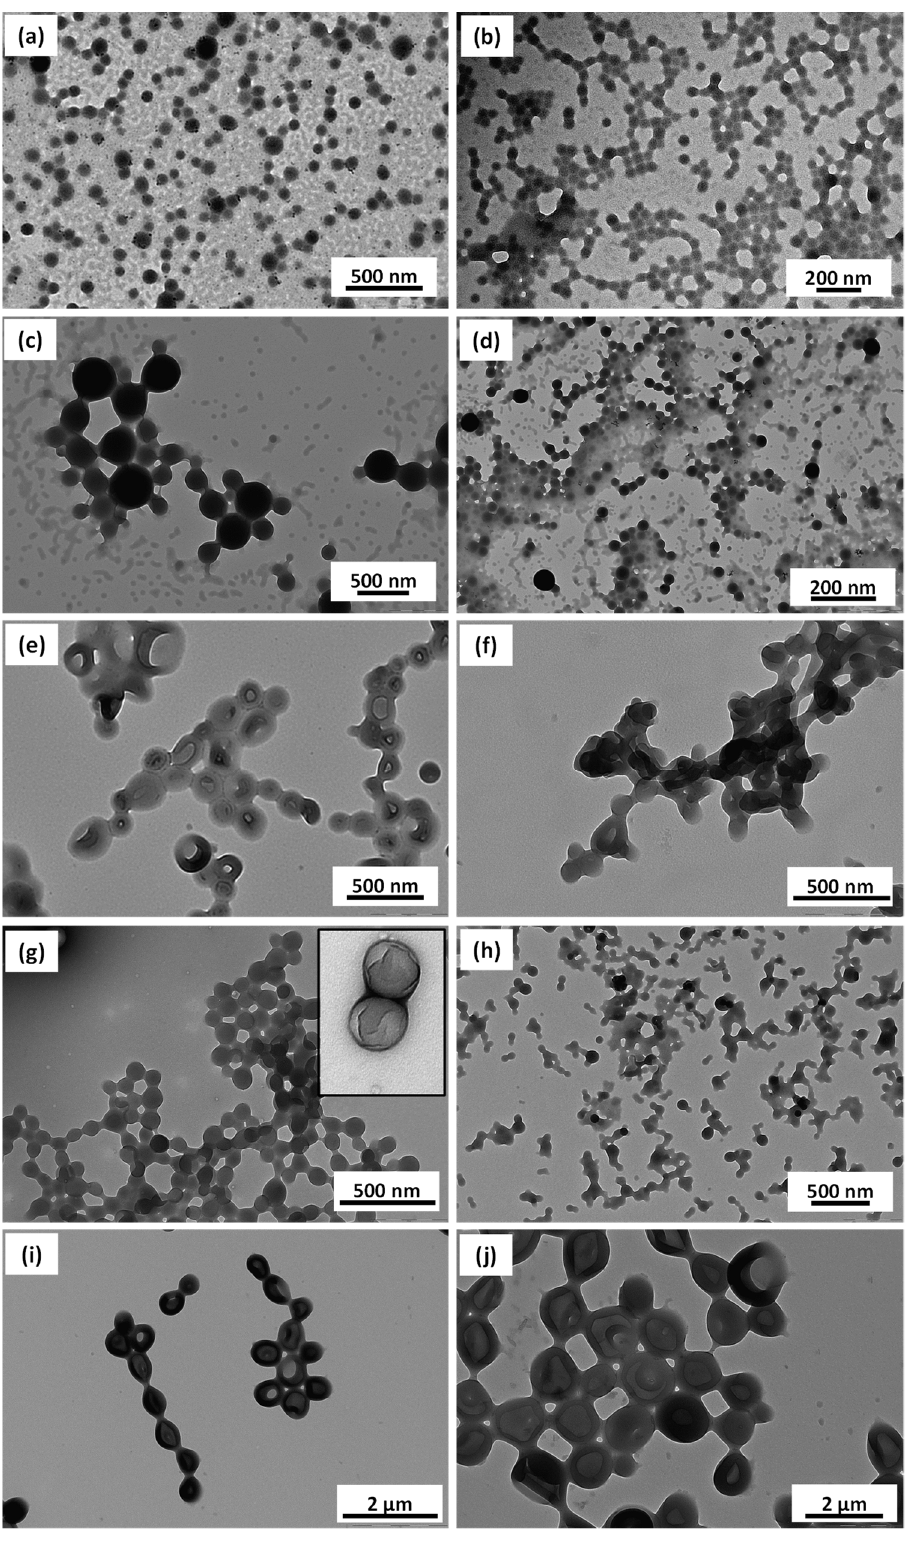
Figure 5. TEM images obtained for PDMA 39 -PBzMA x -PHFBMA y nano objects prepared at 10% w / w with ( a ) x = 69, y = 50 ( b ) x = 69, y = 99 ( c ) x = 69, y = 149 ( d ) x = 69, y = 196 ( e ) x = 99, y = 65 ( f ) x = 149, y = 141 ( g ) x = 198, y = 50 ( h ) x = 198, y = 96 ( i ) x = 198, y = 144 ( j ) x = 198, y = 189. To see the effect of increasing the number of fluorinated units on the phase separation of the two core forming blocks, HFBMA (containing 7 fluorine atoms) was replaced with